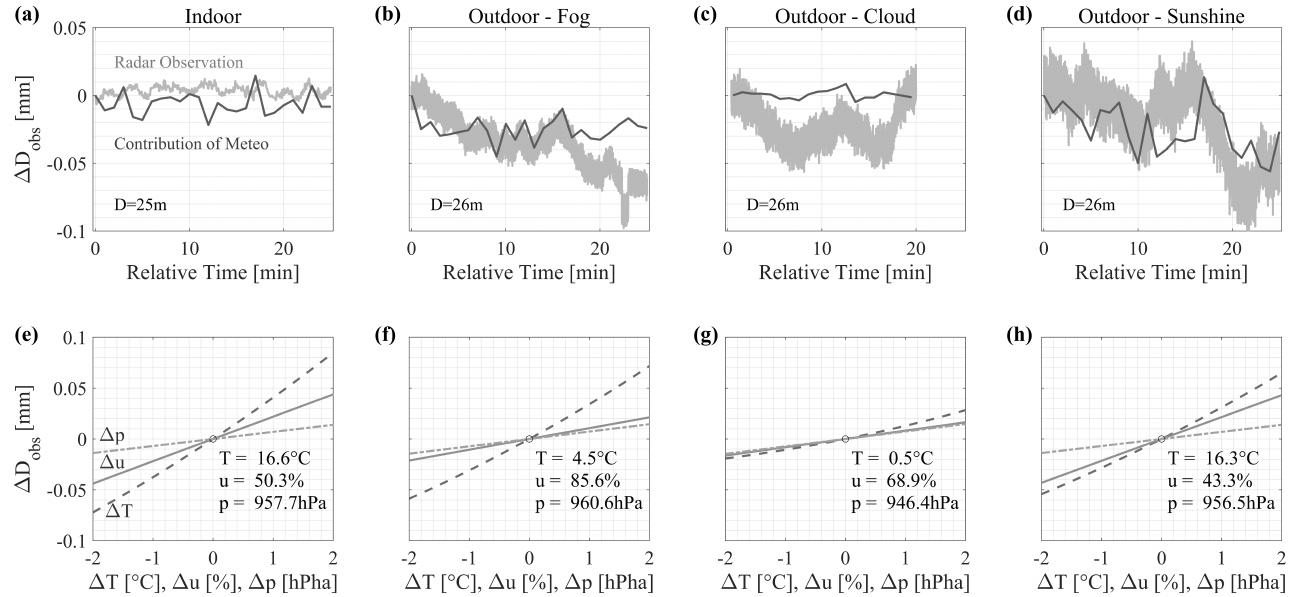
Figure 10. ( a – d ) Relative displacement observed with the radar instrument (light grey) and the calculated influence of the meteorologi- cal conditions measured by a meteorological instrument (dark grey) for targets in distances of 25 to 26m under various meteorological conditions. ( e – h ) Influence of the change ∆ of meteorological properties to the displacement measurement based on the averaged temperature T , relative humidity u , and pressure p while carrying out the